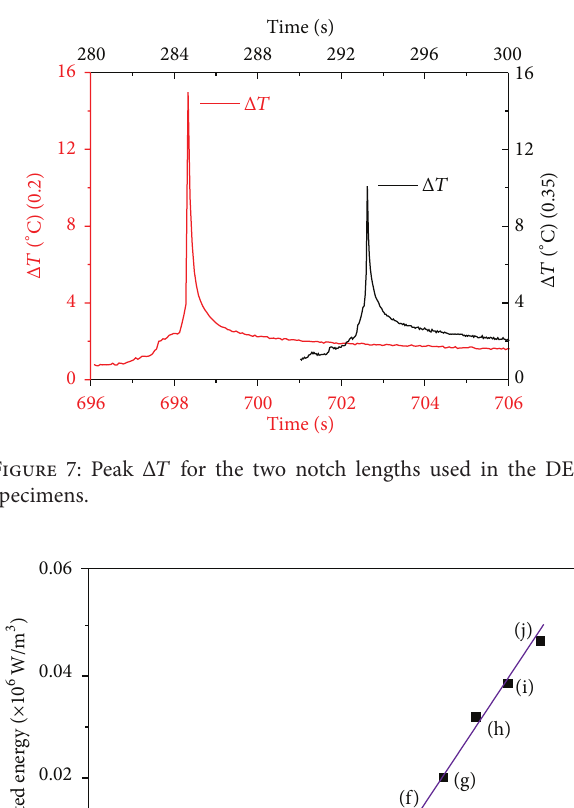
for fatigue-loaded